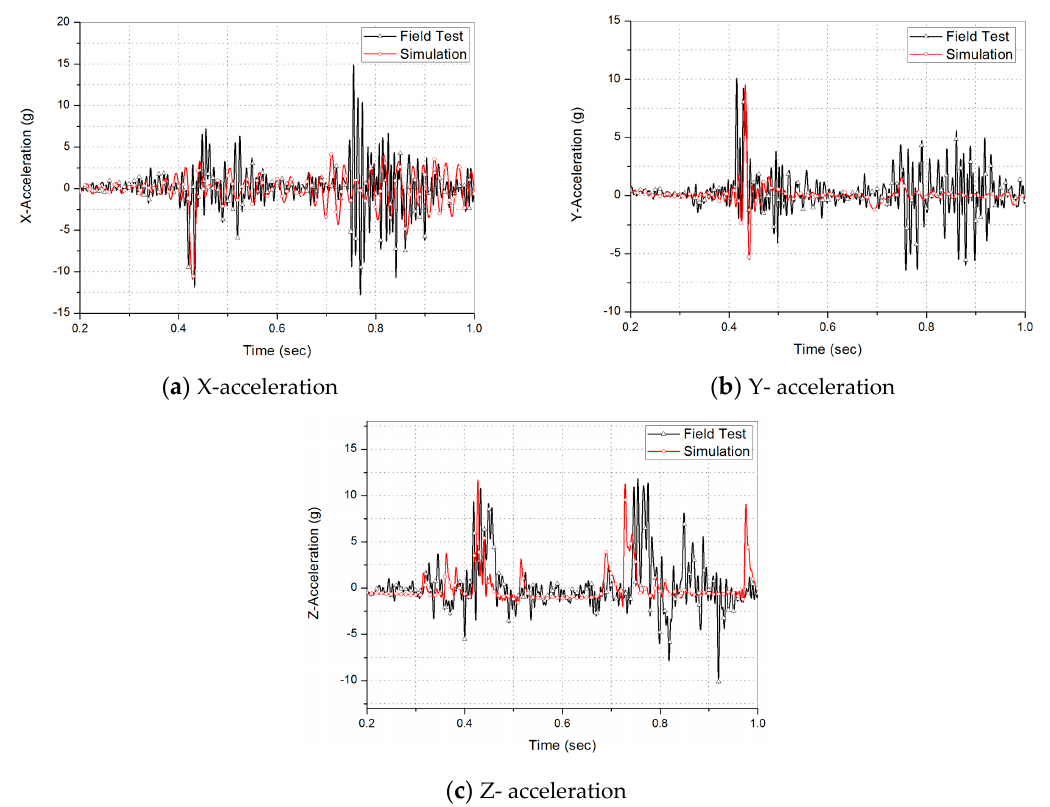
Figure 15. The comparison of acceleration between the field test and the simulation (180 Hz low-pass filter). ( a ) X-acceleration; ( b ) Y-acceleration; ( c ) Z-acceleration. Table 5. The comparison of maximum acceleration.